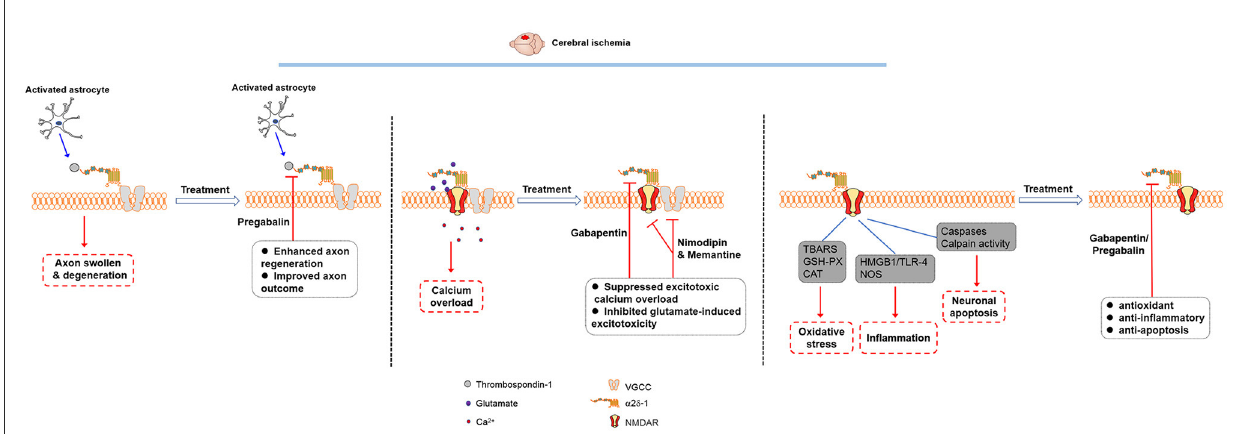
FIGURE1 Molecular mechanisms involved in the therapeutic effects of gabapentinoids in cerebral ischemia. The thrombospondin- α 2 δ -1 interaction may play a role in synaptogenesis, but it is unlikely involved in the gabapentinoid effects on acute cerebral ischemia. Gabapentinoids likely act on α 2 δ -1-bound NMDARs to reduce excitotoxic Ca 2 + overload and glutamate-induced excitotoxicity as well as produce antioxidant, anti-inflammatory, and anti-apoptosis effects in cerebral